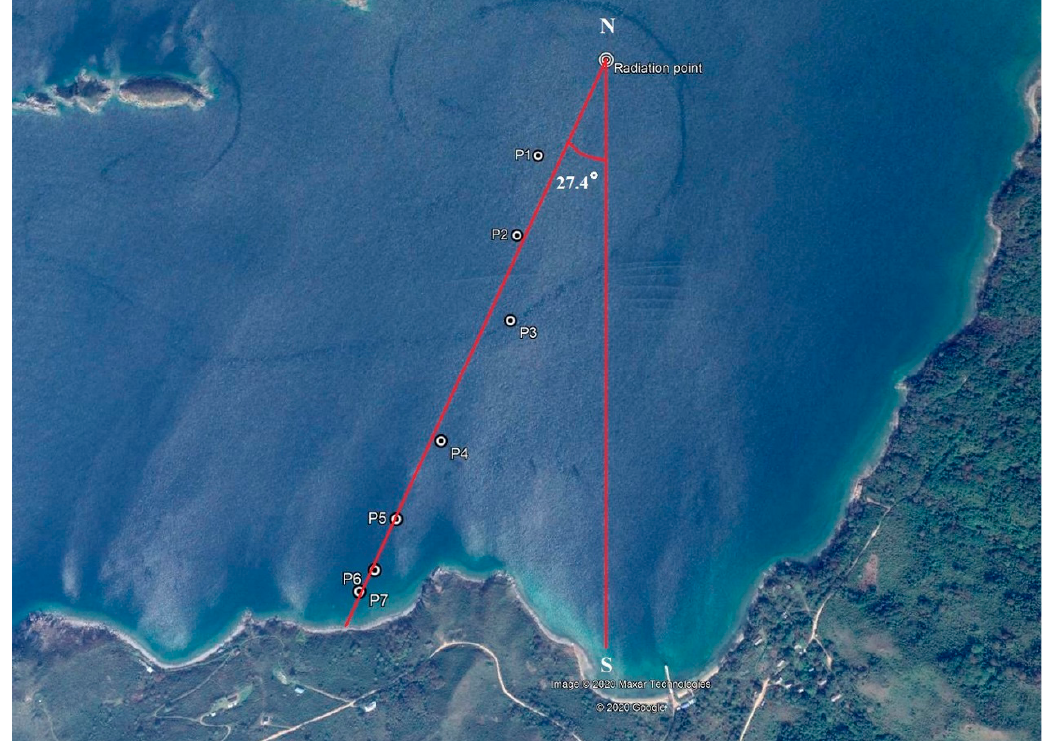
Figure 1. Map scheme of the experiment. The labelled “radiation point” is the location of the vessel with the transmitter. Points P1–P7 show the positions of the receiving stations. The angle 27.4° is the angle between the reception route and the “North–South” direction.